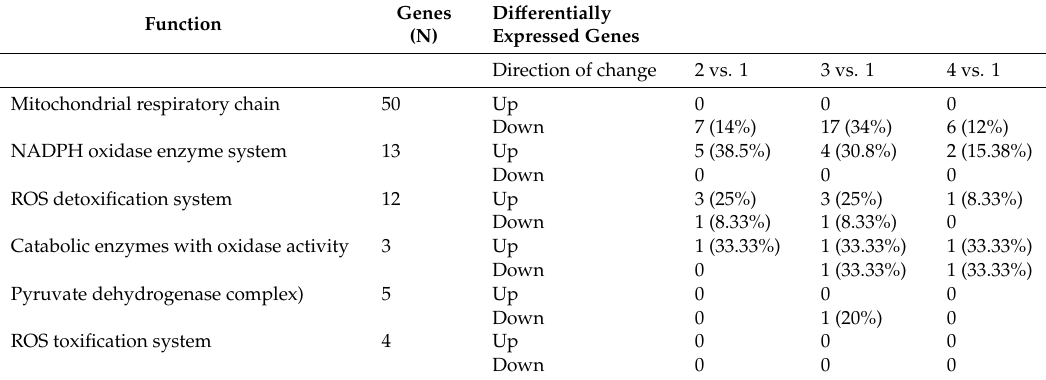
Table 1. Di ff erential expression of manually selected genes functionally associated with the generation and detoxification of ROS in CDV-DL. Genes Function